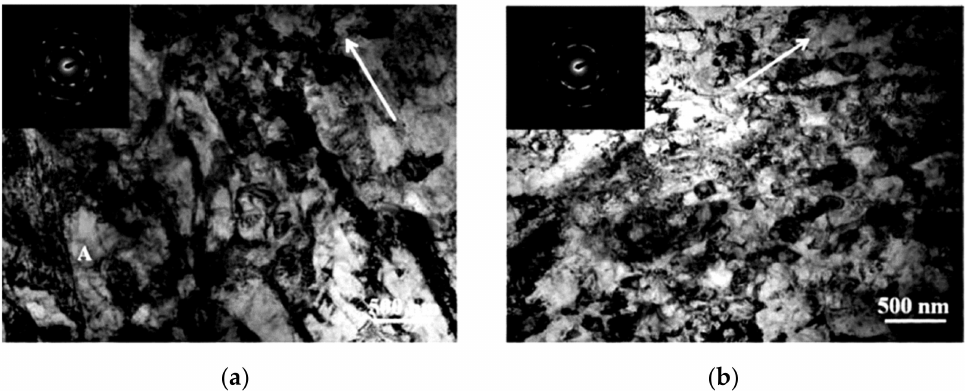
Figure 41. TEM micrographs and the selected area electron diffraction (SAED) pattern of the HRDSR- processed CP-Ti (ASTM grade 2). ( a ) Region with elongated or nearly equiaxed subgrains. ( b ) Region with equiaxed and smaller grains. The arrows indicate the rolling direction, reproduced from [20], with permission from Elsevier,